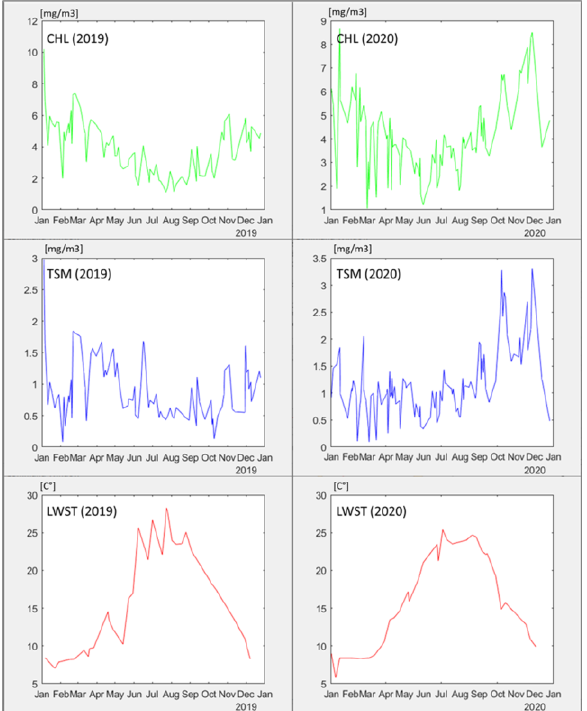
Figure 4. WQPs mean values trends for 2019-2020 for the full